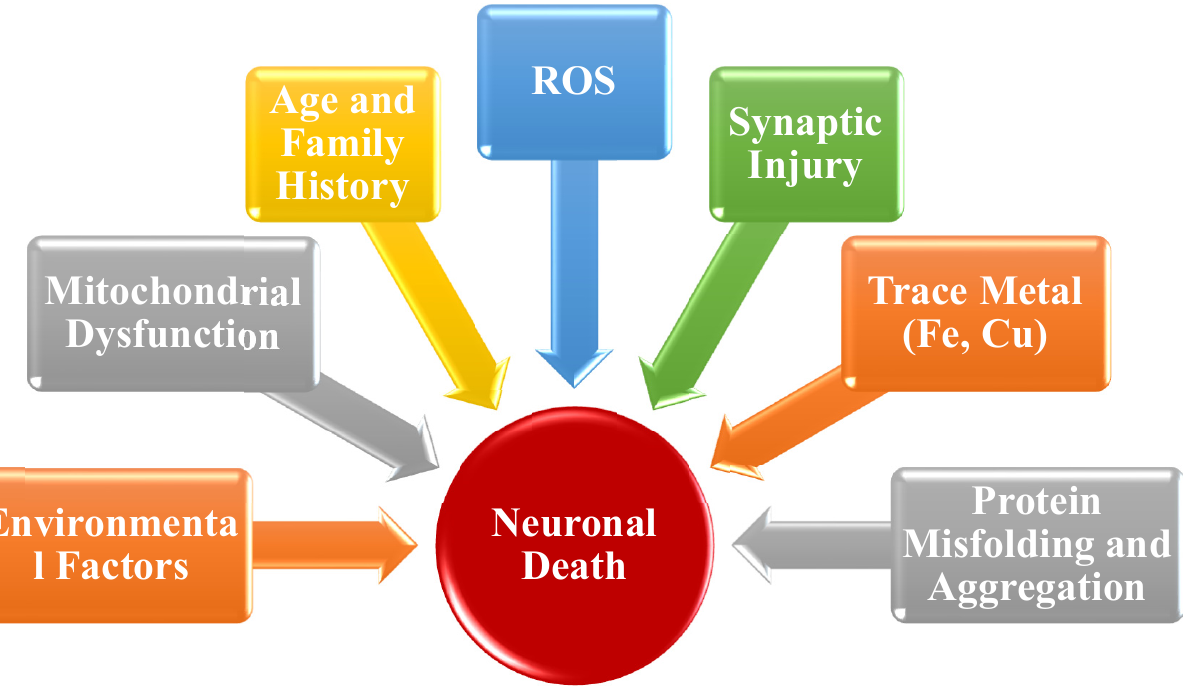
Figure 1. Pathophysiological aspects that can cause neurodegeneration. Neuronal deterioration accelerates with age and is particularly severe in old age, as observed with the numerous neuropathologies. To date, most neurodegenerative diseases have remained incurable. As previously stated, the current ongoing treatment just re- lieves symptoms but does not hinder the disease progression, focusing the need for more effective treatment strategies [5]. Development of new drugs for NDs is hampered by the lack of understanding of the biological perspective of these multifactorial disorders, the blood–brain barrier that prevents drug flow to the brain, and the scarcity of clinically relevant animal models for new drug testing [6]. Although NDs are pathologically char- acterized by disease-specific misfolded protein aggregation and modified cellular stress response, researchers have focused exclusively on reduction in misfolded protein load; however, the outcomes were disappointing [7,8]. Due to the late onset and asymptomatic nature of most neurodegenerative diseases, treatment begins at later disease stages and has restricted benefits to the patients. If interventions are initiated early, they might be able to largely prevent or slow the disease progression. These therapies via lowering or even removing the primary stressor may be able to restore neuronal function